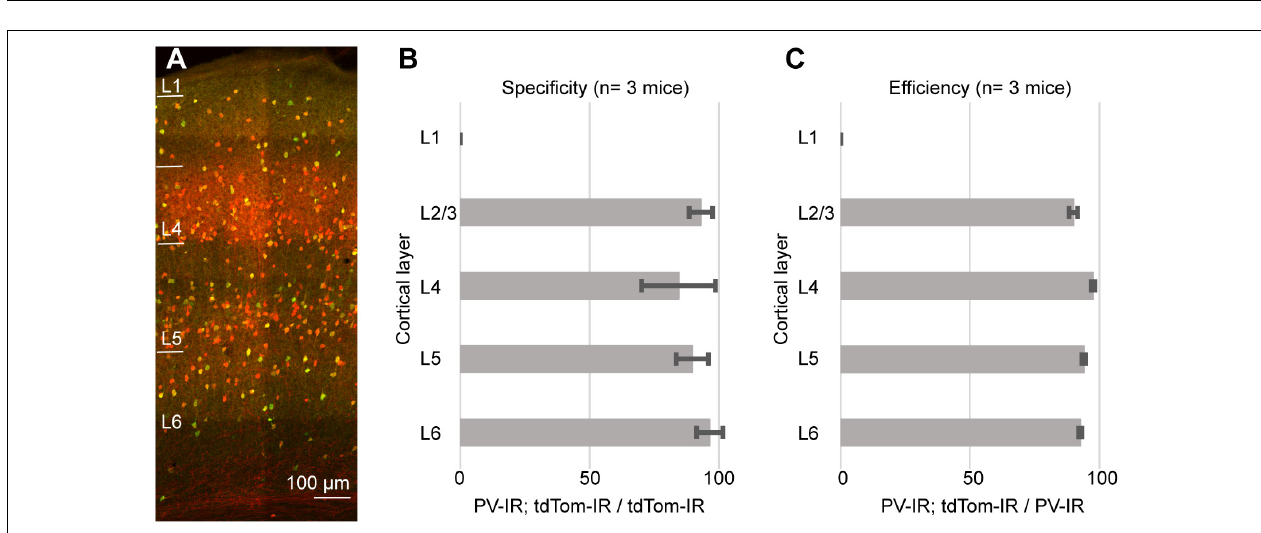
FIGURE 3 | (A) Representative confocal stack showing the overlap of immunofluorescence for PV (green) and tdTomato (red) in PER; yellow arrows indicate double labeled cells and white arrows indicate PV-IR cell that do not express tdTomato. (B) Bar graph showing the specificity of the PV-IRES-Cre mouse line in PER in 4 animals. (C) Bar graph showing the efficacy of the PV-IRES-Cre mouse line in PER in 4 animals.